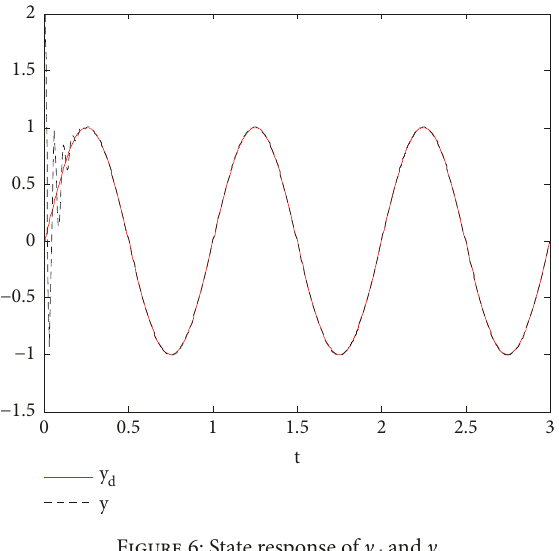
Figure 6: State response of y